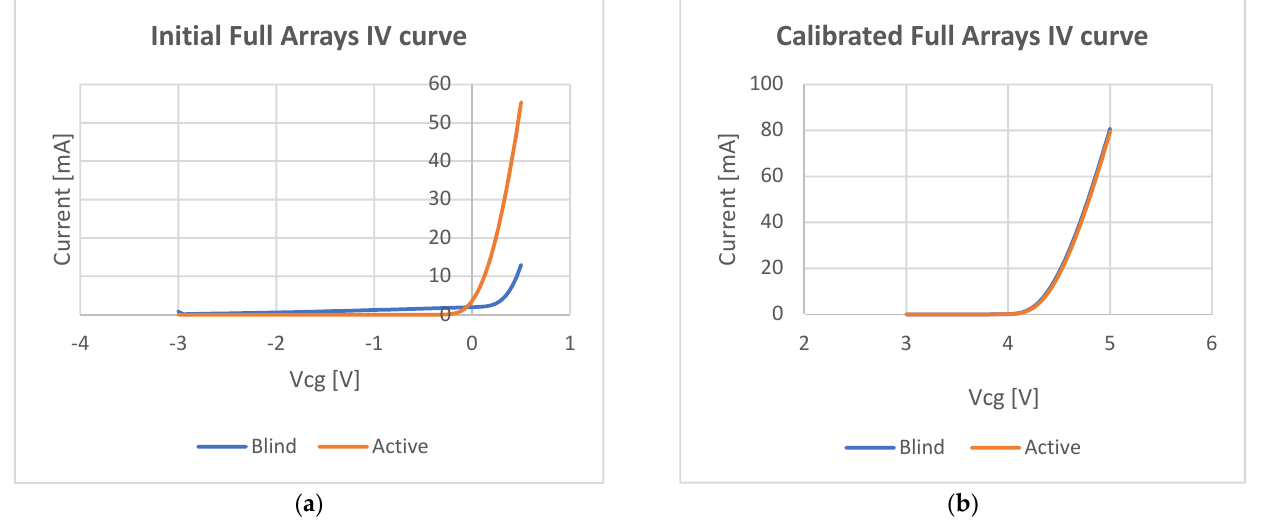
Figure 7. Full Arrays IV Curves. ( a ) initial IV curve; ( b ) calibrated IV curve.